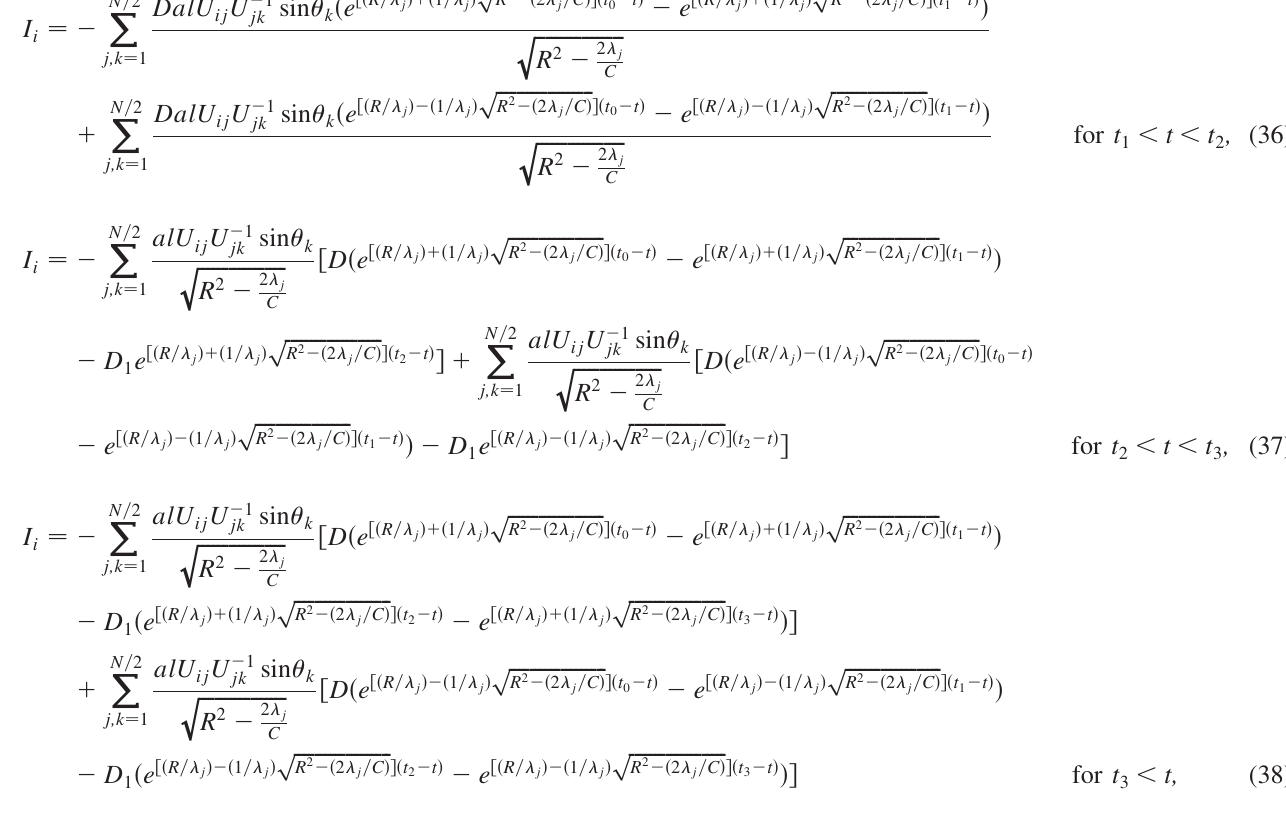
p R 2 (cid:1)ð 2 (cid:4) j =C Þ